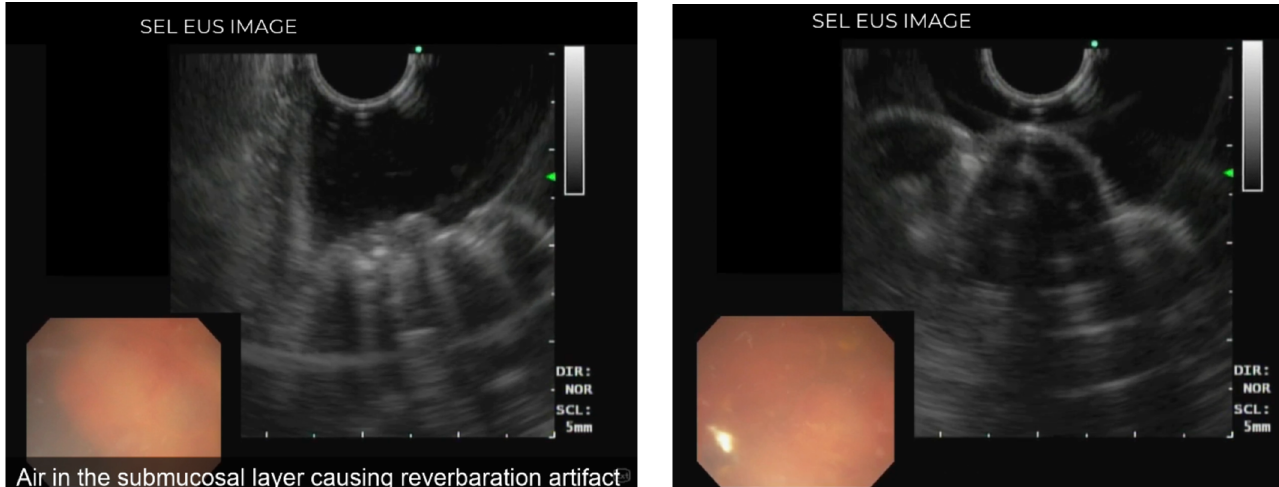
Figure 2. Although the diagnosis can be made by radiological studies [3,4–6], a colorectal EUS and colonoscopy can be made in the same section without radiation and with high precision [4–6]. An Endoscopic Ultrasound (EUS) (Video S1) was performed for lesion evaluation. The ultrasound images showed irregular hyperechoic structures, “dirty shadow”, A-lines, and decreased visualization of deeper structures, air reverberation compatible with gas in the submucosal layer, with no nodules or fl uid inside.